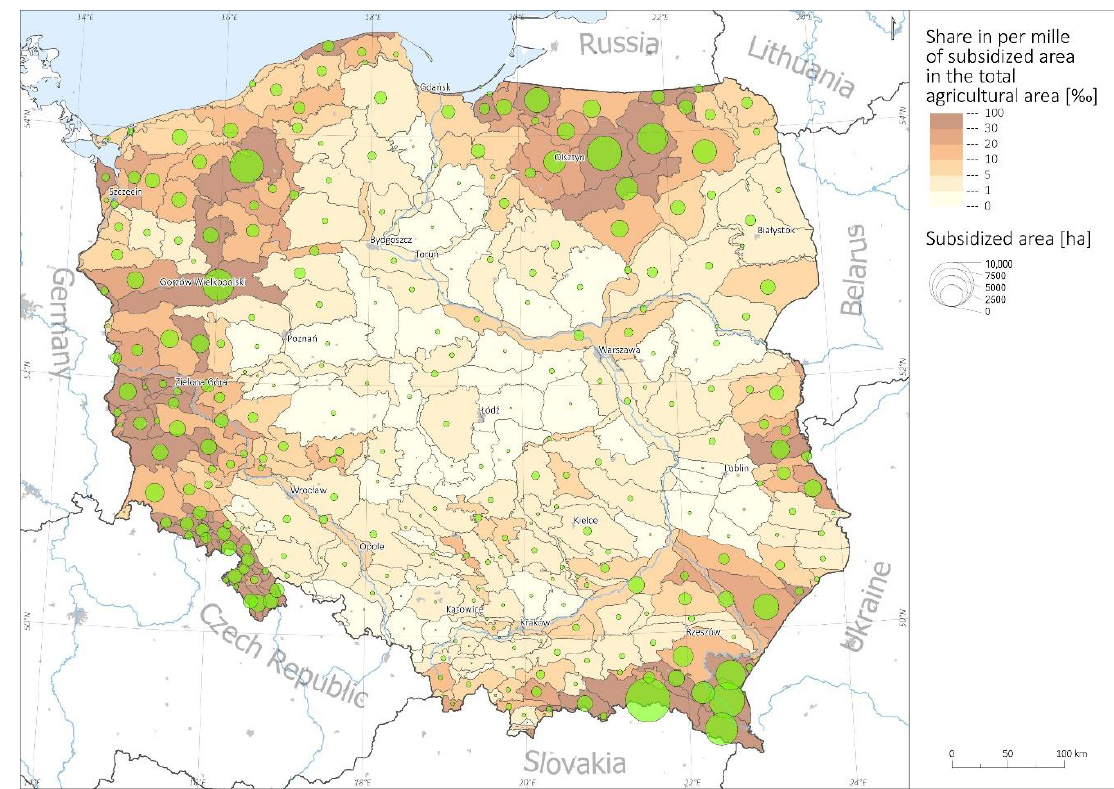
Figure 7. Area of land subsidised to support the protection of semi-natural mesic meadows and their share in the total agricultural area in mesoregions (Source: Authors based on ARMA data).